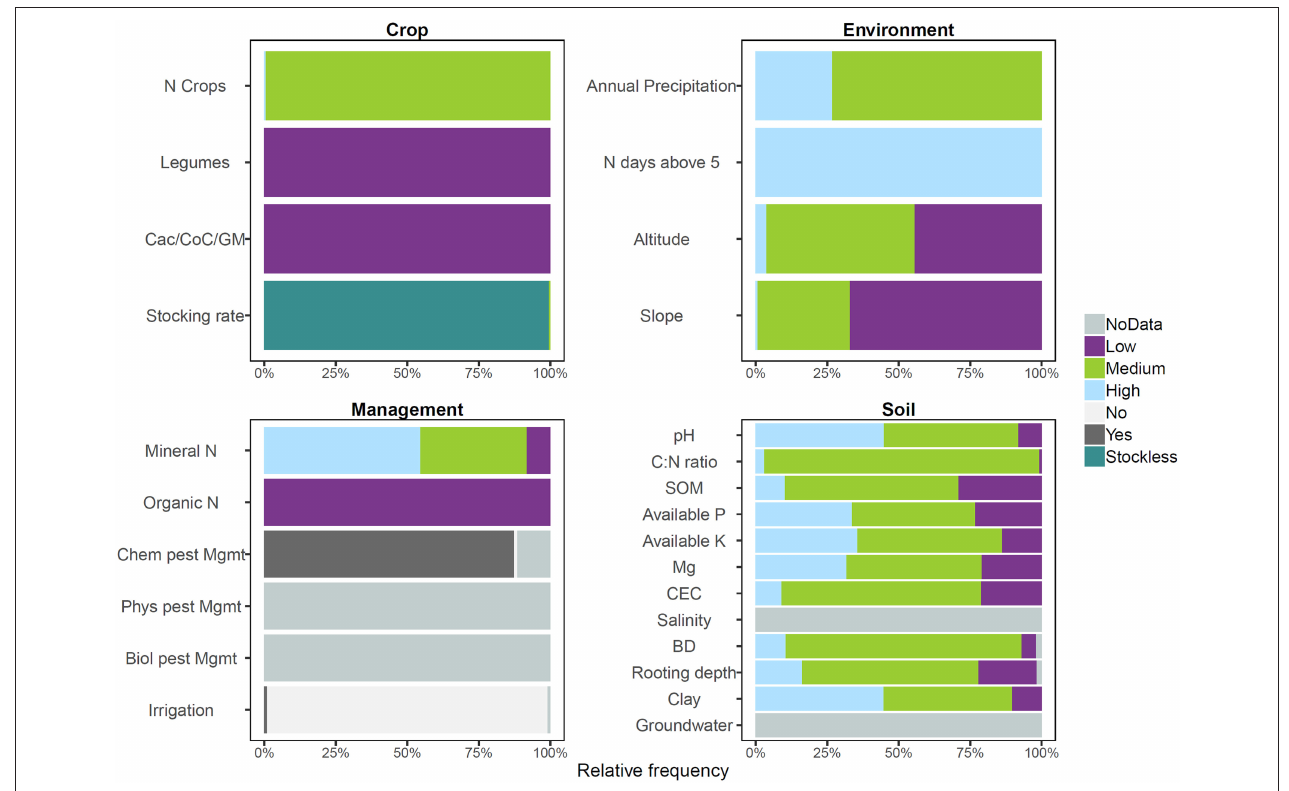
FIGURE 1 | The discretization of the dataset into values corresponding to “Low,” “Medium,” “High,” “Yes,” “No,” and “Stockless”.